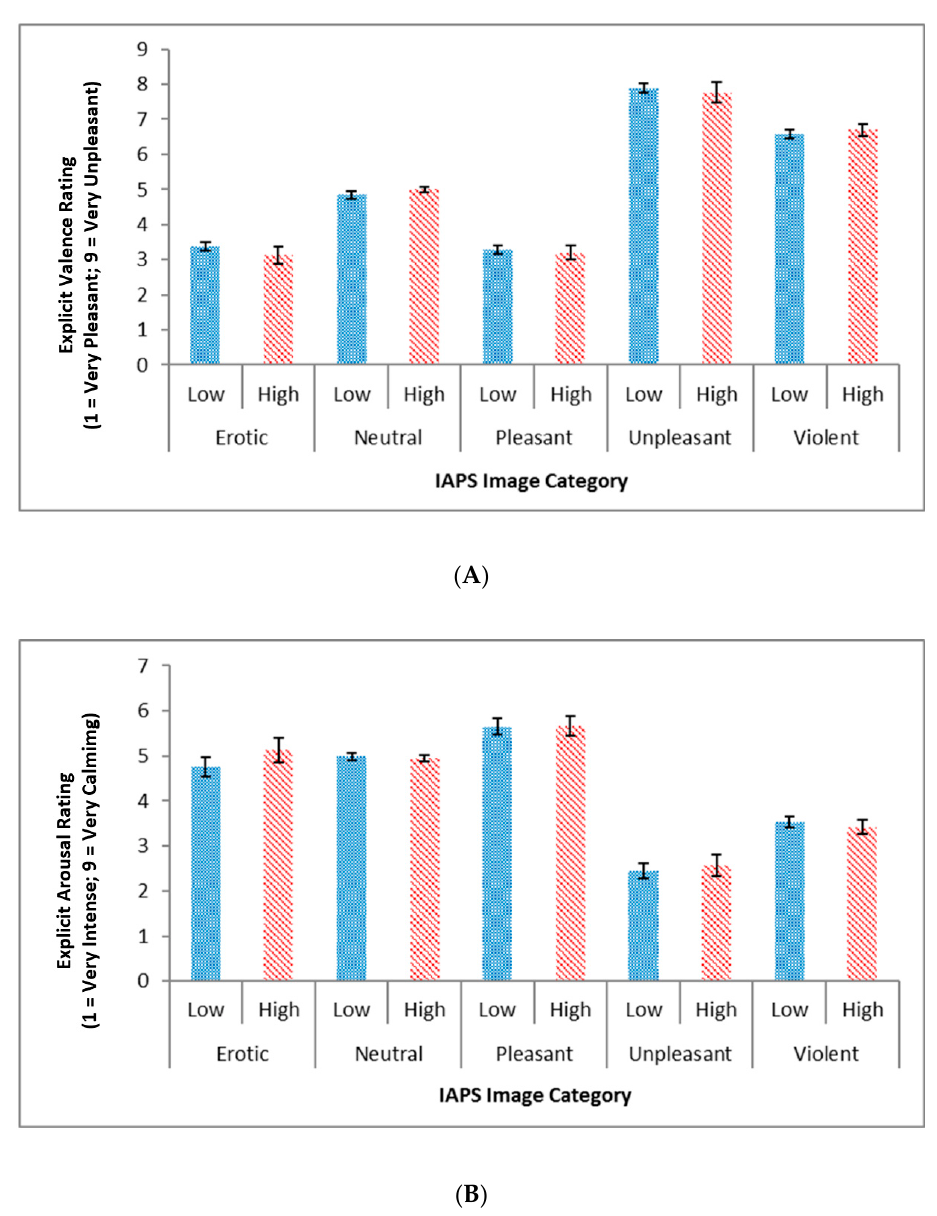
Figure 1. ( A ) Explicit valence rating and ( B ) explicit arousal rating for each emotion category across low and high aggression groups. Note no significant differences were noted in explicit valence and arousal ratings between both high and low aggression groups. IAPS: International Affective Picture System.